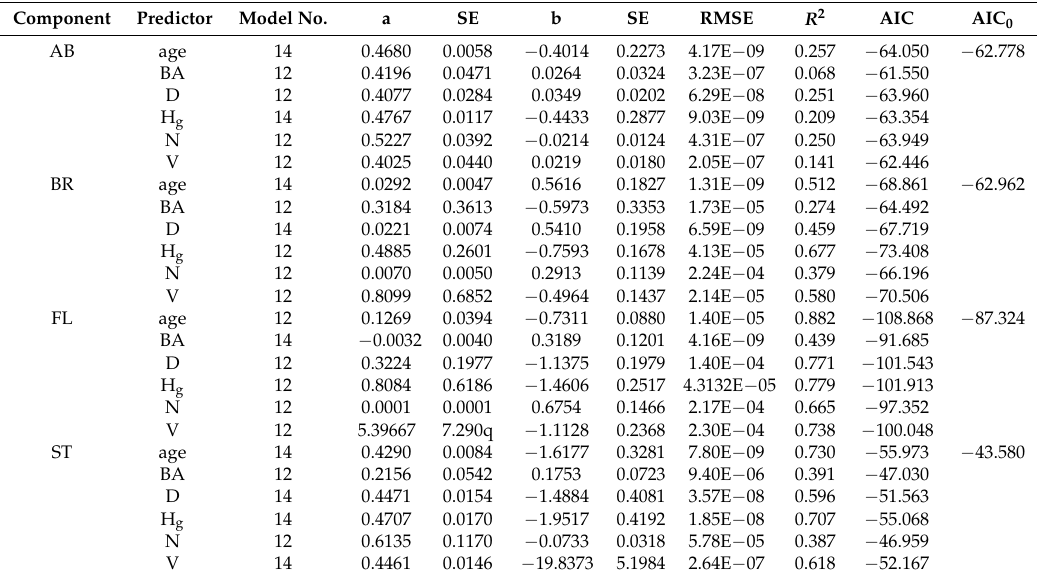
Table 5. Relationships between forest stand characteristics (predictors) and BCEFs for particular biomass components (Mg m − 3 ), excluding the youngest stand (7 years old). Component